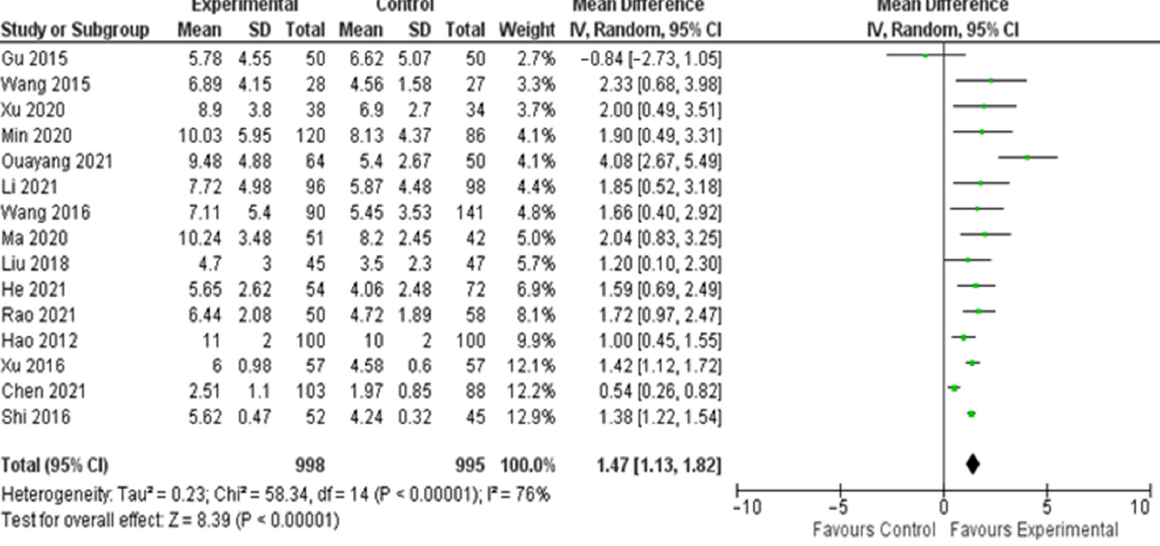
Figure 3. Forest plot of the metastatic lymph nodes harvested. Regarding the number of parathyroid glands that were accidentally removed during the operations, the meta-analysis from the available data from thirteen studies showed that there was a statistically significant 34% decreased chance of accidental removal of a parathyroid gland in the carbon nanoparticle suspension group (OR 0.34, CI 95% 0.24 to 0.50, p < 0.001). For this calculation, a fixed model was applied as the data were homoge- neous (I 2 = 14%, p = 0.31). This outcome is portrayed in Figure 4.